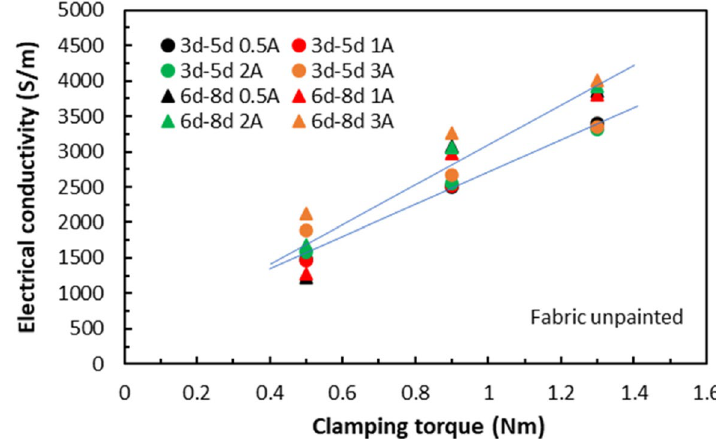
Fig. 16 Effect of clamping torque on in-plane electrical conductivity for unpainted carbon/epoxy laminates